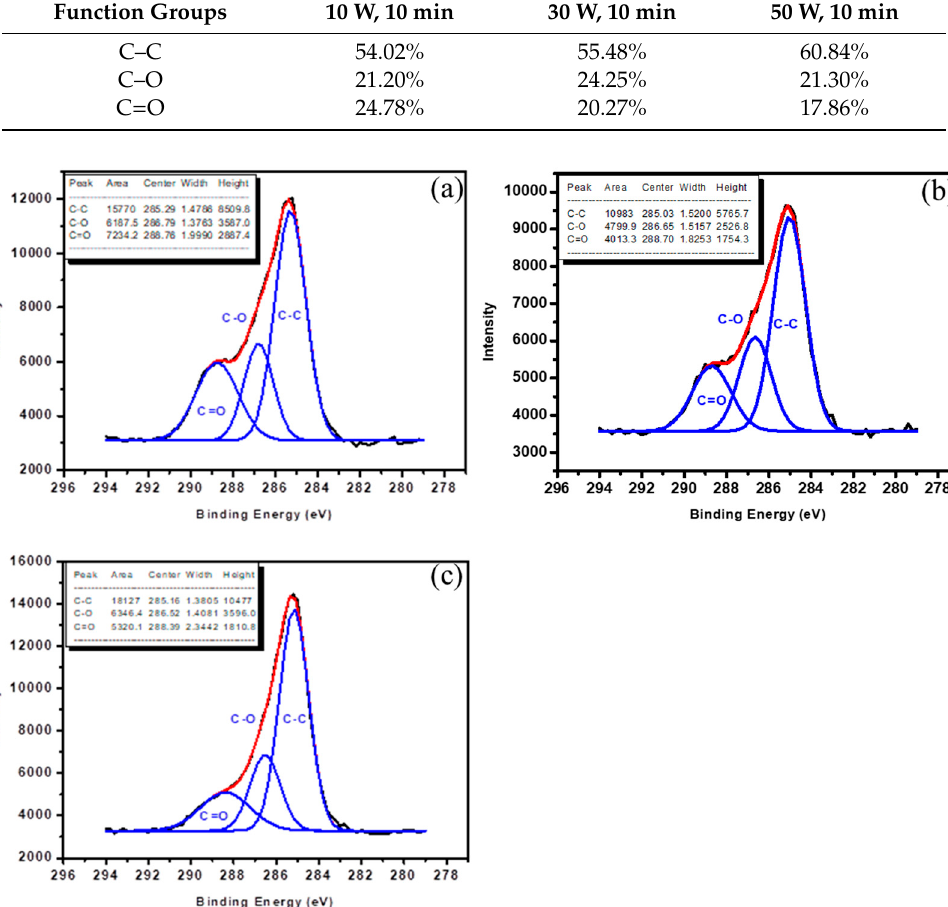
Figure 4. Electron spectroscopy for chemical analysis (ESCA) C1s spectra of ( a ) acetic acid film (10 W, 10 min), ( b ) acetic acid film (30 W, 10 min), ( c ) acetic acid film (50 W, 10 min).